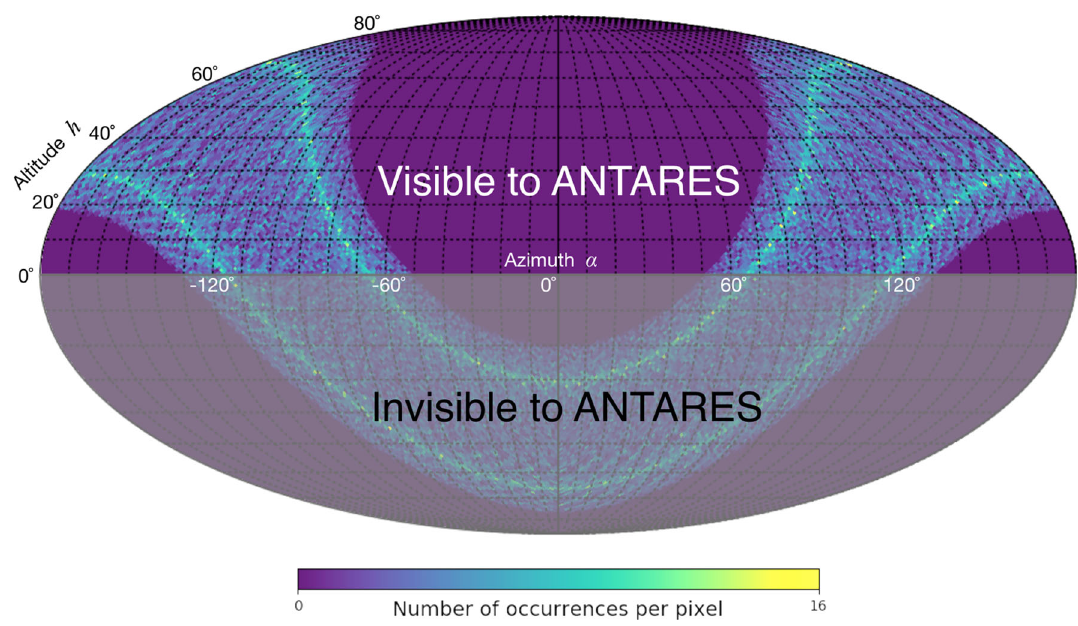
Fig. 1 The visible and invisible sectors of the position of the Moon for ANTARES with respect to the detector horizontal coordinate system. The occurrences of the Moon position are computed at each hour in the period 2007–2016 with the library SkyField [22]. The map is arranged